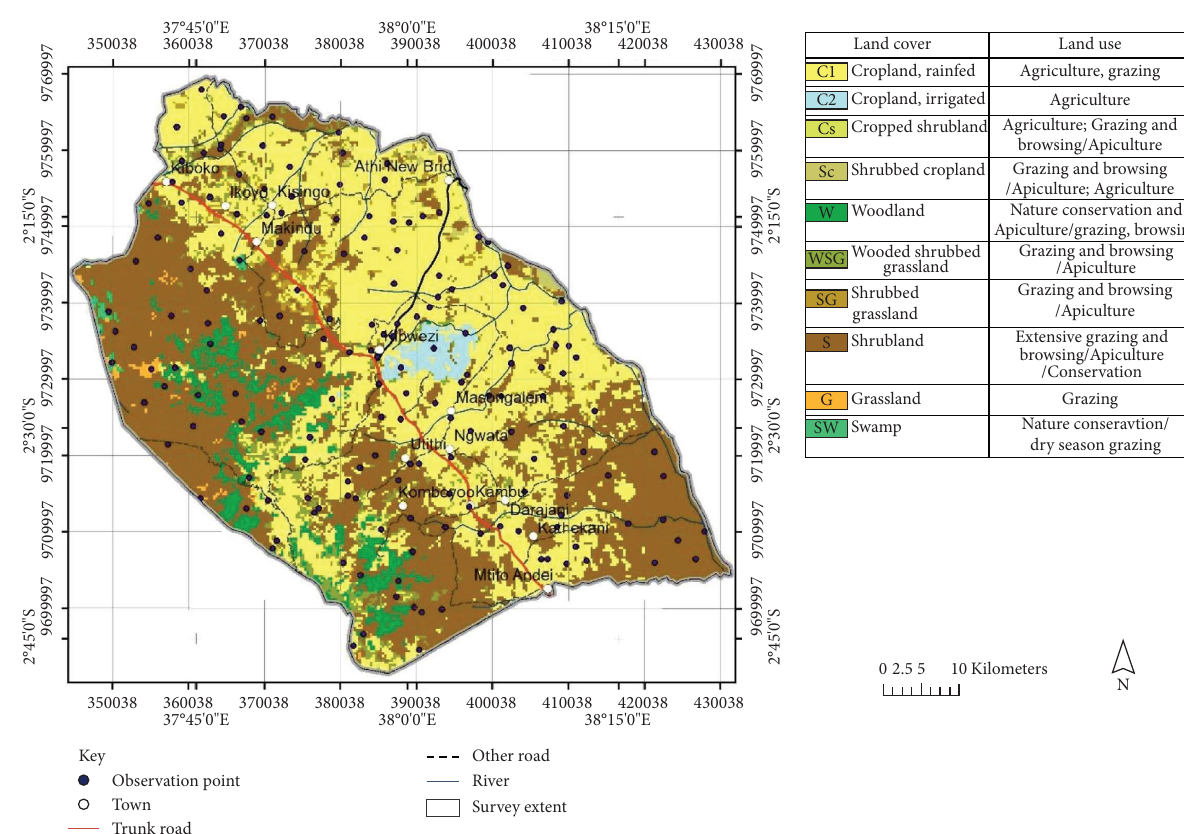
Figure 4: Preclassifed land cover